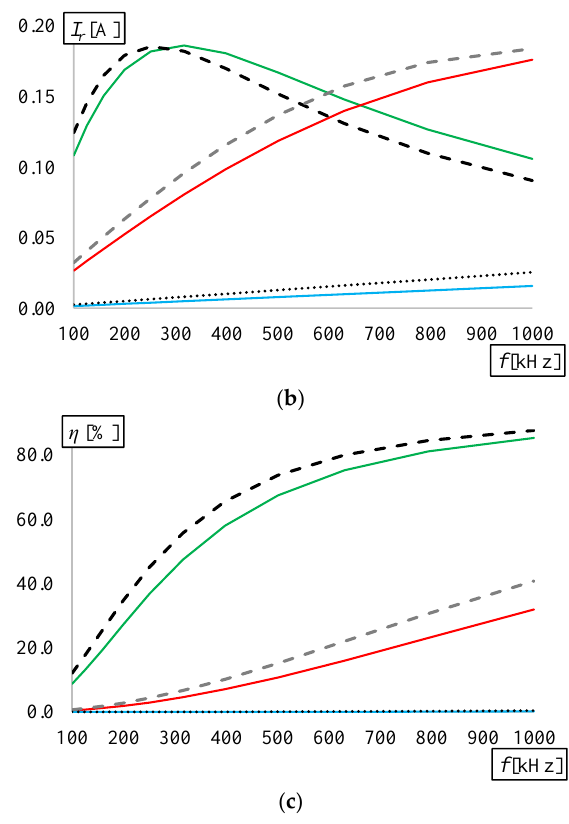
Figure 10. Results for the case r c = 20 mm, n c = 30: ( a ) transmitter current, ( b ) receiver current, and ( c ) power transfer efficiency.